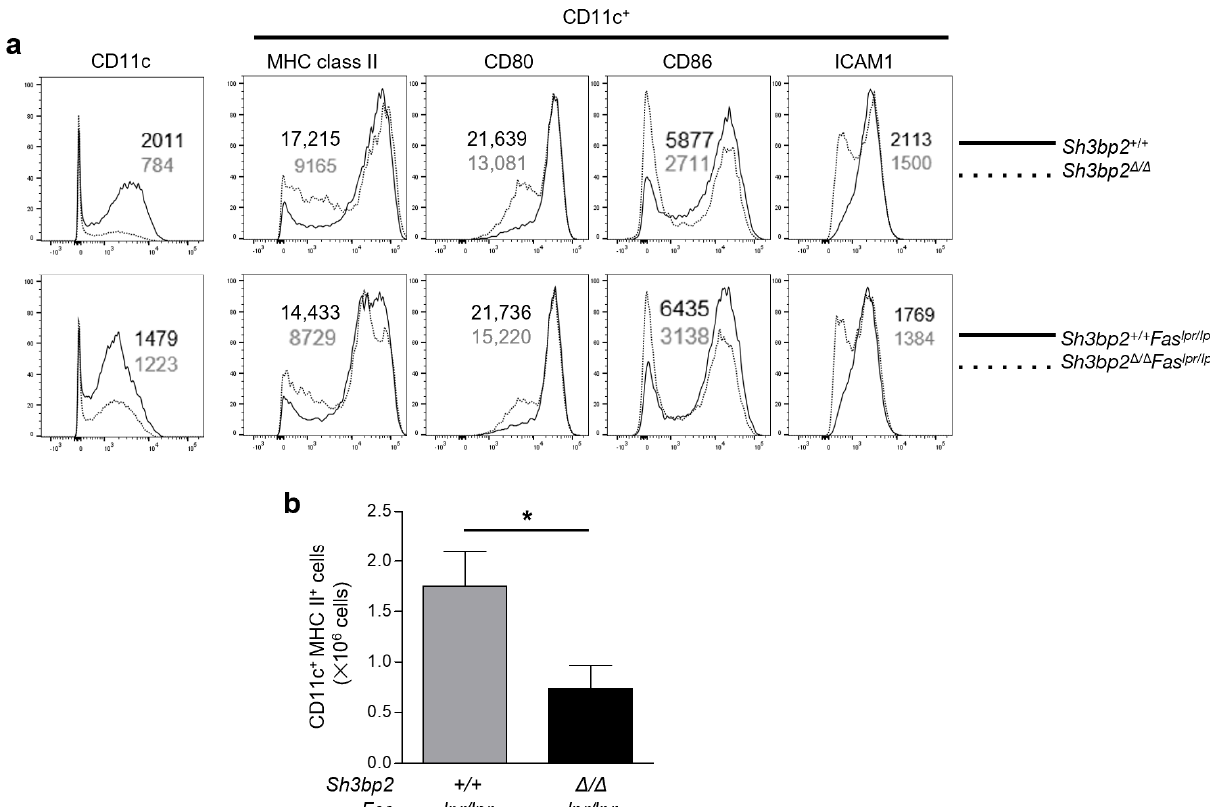
Figure 4. SH3BP2 deficiency suppresses the differentiation of dendritic cells. ( a ) Flow cytometric analyses of cell sur- face markers on dendritic cells. Bone marrow cells were isolated from 16-week-old Sh3bp2 +/+ , Sh3bp2 ∆ / ∆ , Fas lpr/lpr , and Sh3bp2 ∆ / ∆ Fas lpr/lpr mice. After a 10-day pre-culture with GM-CSF and IL-4, yielded bone marrow-derived dendritic cells were analyzed by flow cytometry. Representative histograms show the expression levels of CD11c gated on live cells and MHC class II, CD80, CD86, and ICAM1 (CD54) gated on CD11c + cells. Data were obtained from at least two indepen- dent experiments. Values are the mean fluorescence intensities of the cells. ( b ) Flow cytometric analyses of the splenic cells. Spleen cells were collected from Fas lpr/lpr and Sh3bp2 ∆ / ∆ Fas lpr/lpr ( n = 3) mice at 30 weeks of age and stained with fluorochrome-labeled antibodies against CD11c and MHC class II. Total numbers of CD11c + MHC class II + cells in the spleen were determined. Values are presented as the mean ± SD. * p <